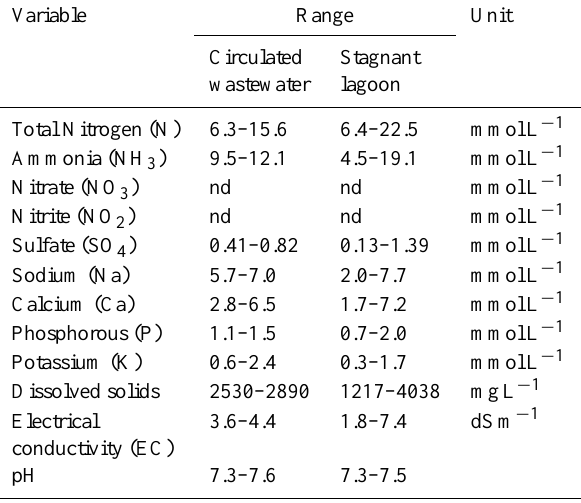
Table 1. Composition of dairy wastewater derived from lagoons in two dairy farms in the San Joaquin Valley, in Central California. Each farm at the time had about 800 Holstein milking cows and both lagoons had about 95millionL holding capacity. The lagoon where the samples for the circulated wastewater were collected uses three circulators, while the stagnant lagoon was not outfitted with anything similar. The values reported are for samples that were col- lected over a year (McGarvey et al.,